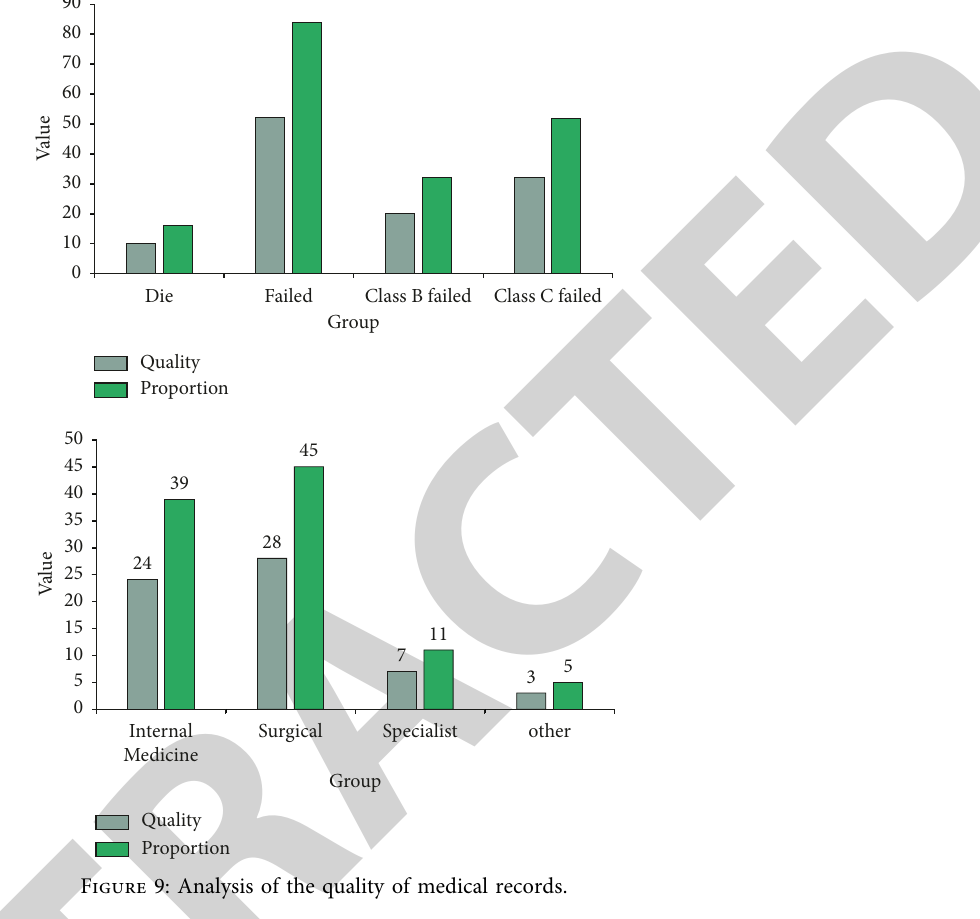
Figure 9: Analysis of the quality of medical